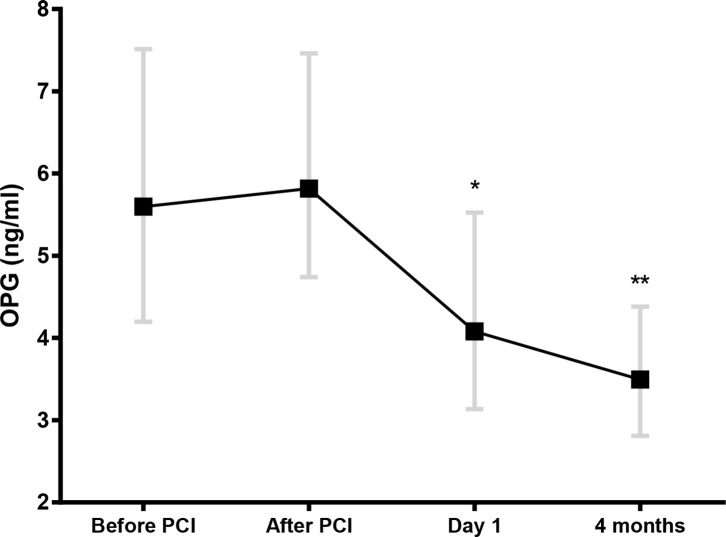
Temporal profile of osteoprotegerin (OPG) during the course of STEMI.OPG was measured in 255 patients with STEMI at the beginning and immediately after the PCI procedure, at Day 1 (median 14.7 hours after PCI), and at 4-month follow-up. Data are presented as median (boxes) with 25th and 75th percentile (whiskers). *p<0.001 for change in OPG levels from before PCI; **p<0.001 for both change in OPG levels from before PCI and from Day 1. Inset: OPG levels in patients treated with iPost or control.